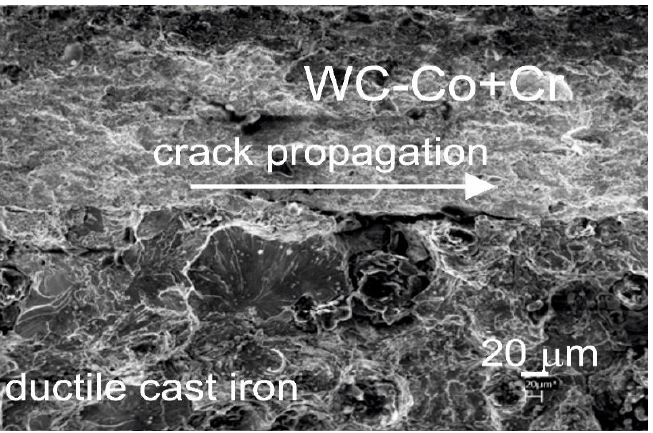
Figure 9. Scanning micrographs of the fracture surface of the WC – Co + Cr/ductile cast iron system after bend test.